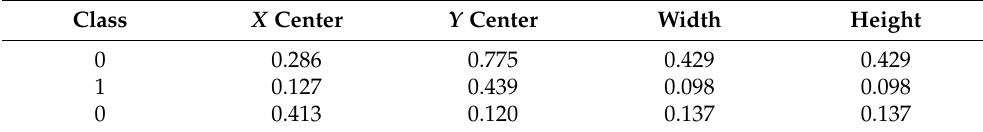
Table 3. Example of YOLO annotation file format.